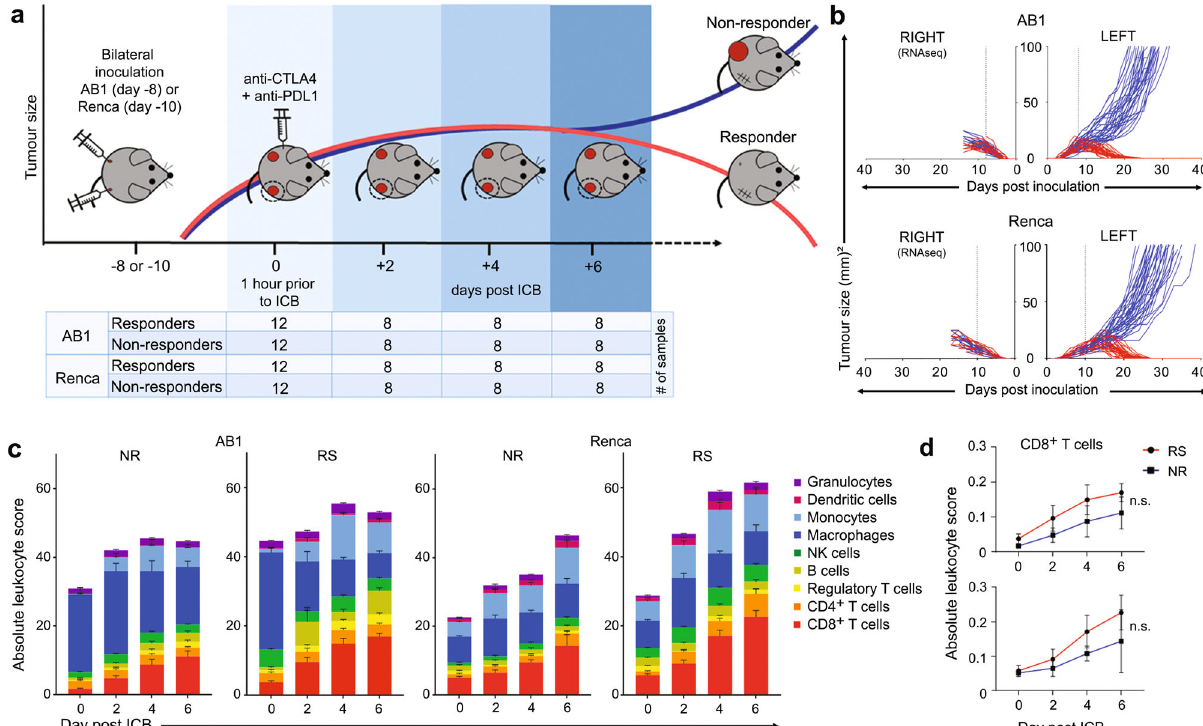
Fig. 1 | Dual tumour models allow time-course analyses of tumours from responders and non-responders to ICB, demonstrating increased lymphoid cellular in fi ltration following treatment, irrespective of response. a One tumour from mice with bilateral AB1 or Renca tumours was harvested for RNAseq either 1h prior to, or 2, 4 or 6 days after ICB, whilst the remaining tumour was monitored for response ( n =144 biologically independent samples from 19 independent experiments). b Growth curves of the removed right and remaining left tumour, allowing classi fi cation of the responder (red) or non-